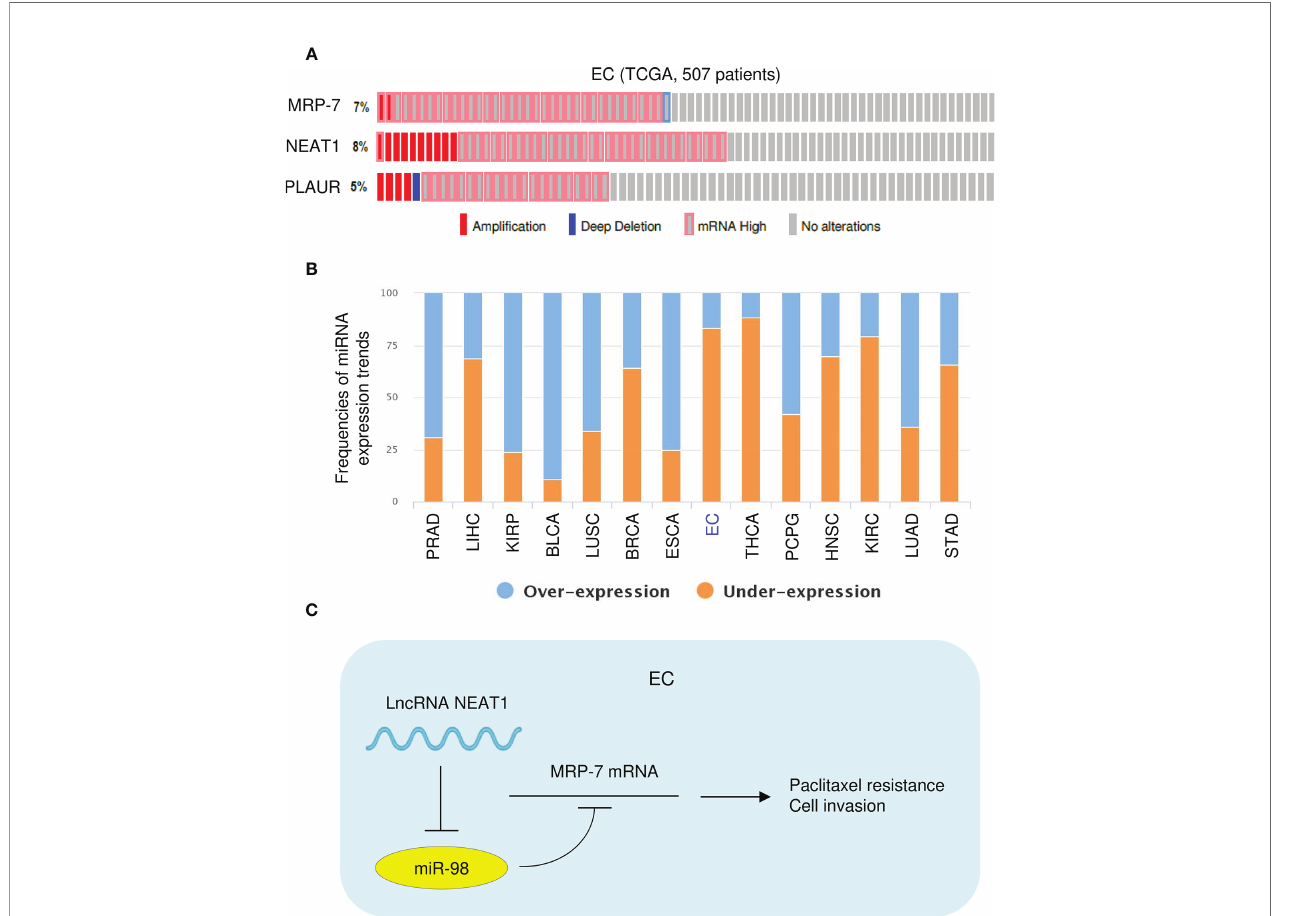
FIGURE 11 | High NEAT, MRP-7 , and PLAUR expression, and Low MiR-98 Expression in TCGA EC Tissues. (A) Genomic alteration frequencies of NEAT1, MRP-7 , and PLAUR were derived from cBioPortal using TCGA EC data. (B) The BioXpress database was used to determine the expression of miR-98 in tumor and normal tissues. (C) The schematic diagram of this study: lncRNA NEAT1 suppresses miR-98 expression to facilitate paclitaxel resistance in EC cells via upregulating MRP-7 and PLAUR